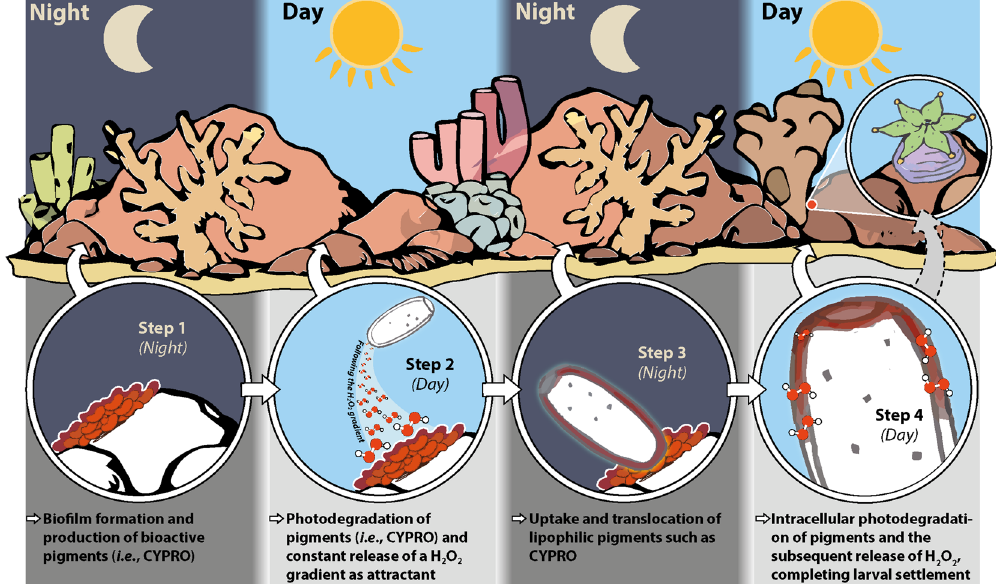
Figure 4. Conceptual model of cycloprodigiosin (CYPRO) and H 2 O 2 induced settlement in coral larvae. Microbial biofilms consisting of settlement-inducing bacteria such as Pseudoalteromonas rubra assemble on marine hard substrates and continue to produce bioactive pigments like CYPRO ( Step 1 ). During phases of high light intensity, the photosensitive pigments bleach and establish an H 2 O 2 gradient that attracts coral larvae ( Step 2 ). Following the gradient, coral larvae encounter, accumulate and utilize intact lipophilic pigments for the following transformation ( Step 3 ). Eventually, the light-driven degradation of accumulated pigments releases elevated intracellular levels of H 2 O 2 that seems to be crucial for the transformation into coral recruits ( Step 4 ) and eventually juvenile